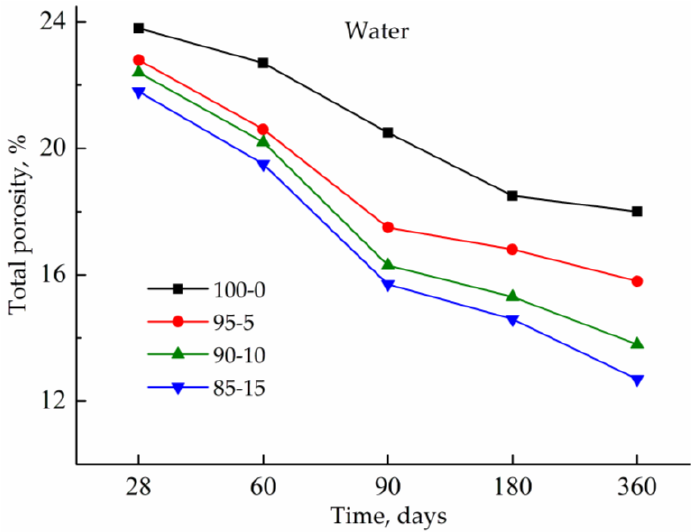
Figure 5. Total porosity of the mixed cement samples hardened in water.